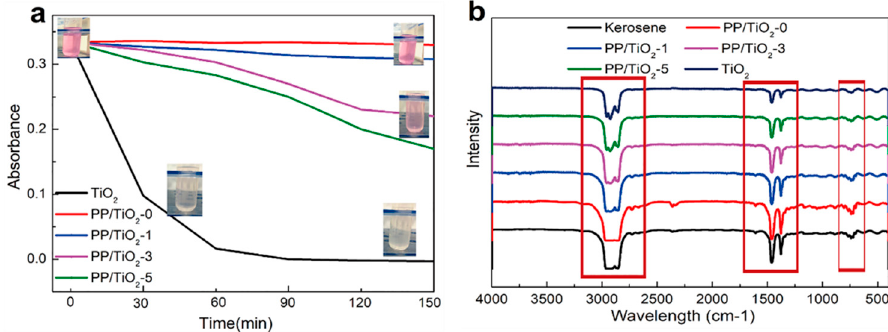
Figure 8. ( a ) The absorbance of rhodamine B along with time and ( b ) FTIR spectrum of kerosene photocatalysis PP/TiO 2 melt-blown membranes.